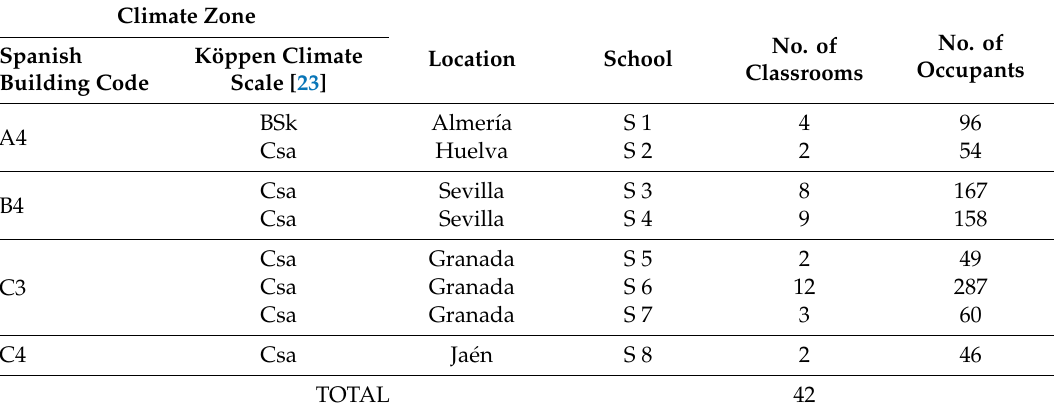
Table 1. Sample by climate